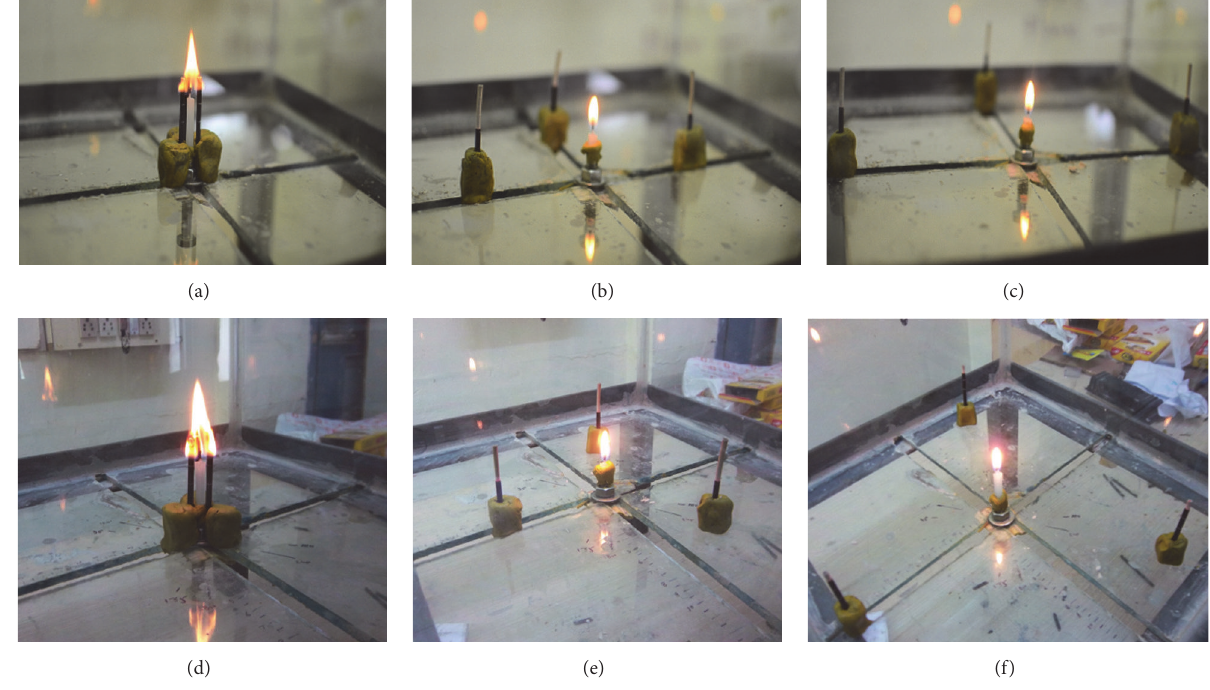
Figure 16: Pictorial view of the three incense sticks’ configuration “T” orientation at (a) 0.5 cm, (b) 7.5cm, and (c) 13 cm and “Y” orientation at (d) 0.5 cm, (e) 7.5cm, and (f)